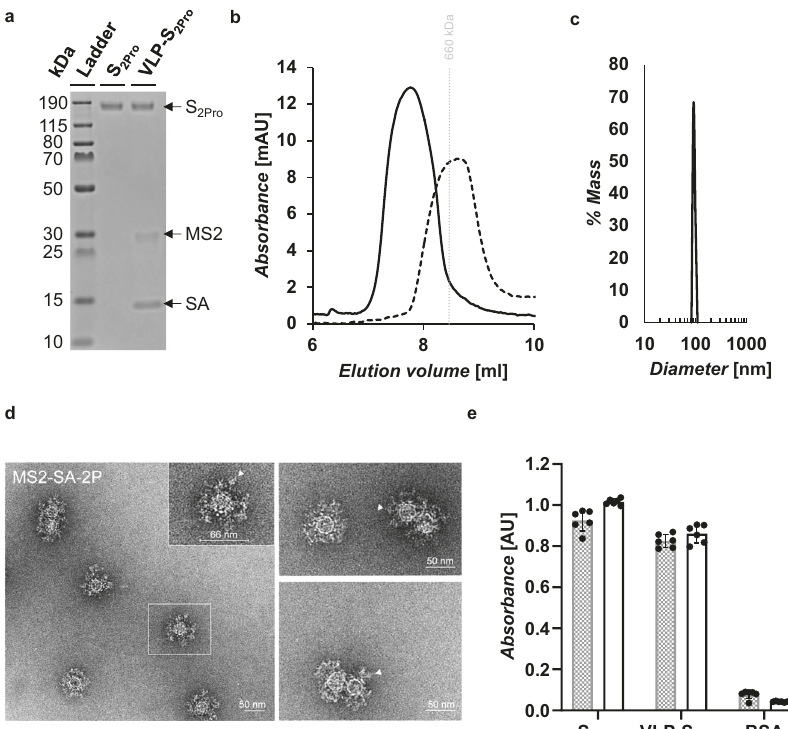
Fig. 2 Characterization of S2Pro and VLP-S2Pro. a SDS-PAGE characterization of S 2Pro and VLP-S 2Pro . The VLP-S 2Pro has been boiled to disrupt the streptavidin-biotin conjugation. The unprocessed gel is shown in Supplementary Fig. 3. b Size exclusion chromatography traces for S 2Pro (dashed line) and VLP-S 2Pro (solid line). The vertical gray line represents the peak elution volume of the molecular weight standard thyroglobulin (660 kDa). The column void volume is 7.2 mL. c Characterization of the VLP-S 2Pro (solid line) by dynamic light scattering. d Negative-stain transmission electron micrographs of S 2Pro incorporated on the surface of MS2-SA VLPs. Arrowheads (white) indicate the S 2Pro proteins on the VLP surface. e Characterization of the binding of Fc- ACE2 (gray) and CR3022 (white) to S 2Pro and VLP-S 2Pro by ELISA (mean ± SD, n = 6: two independent assays, each with three technical replicates). Source data are provided in Supplementary Data